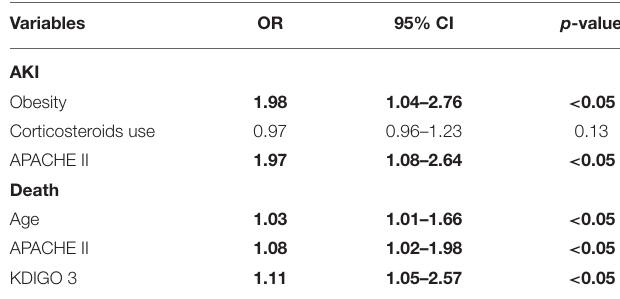
TABLE 6 | Logistic regression of variables associated with AKI and death in patients admitted in